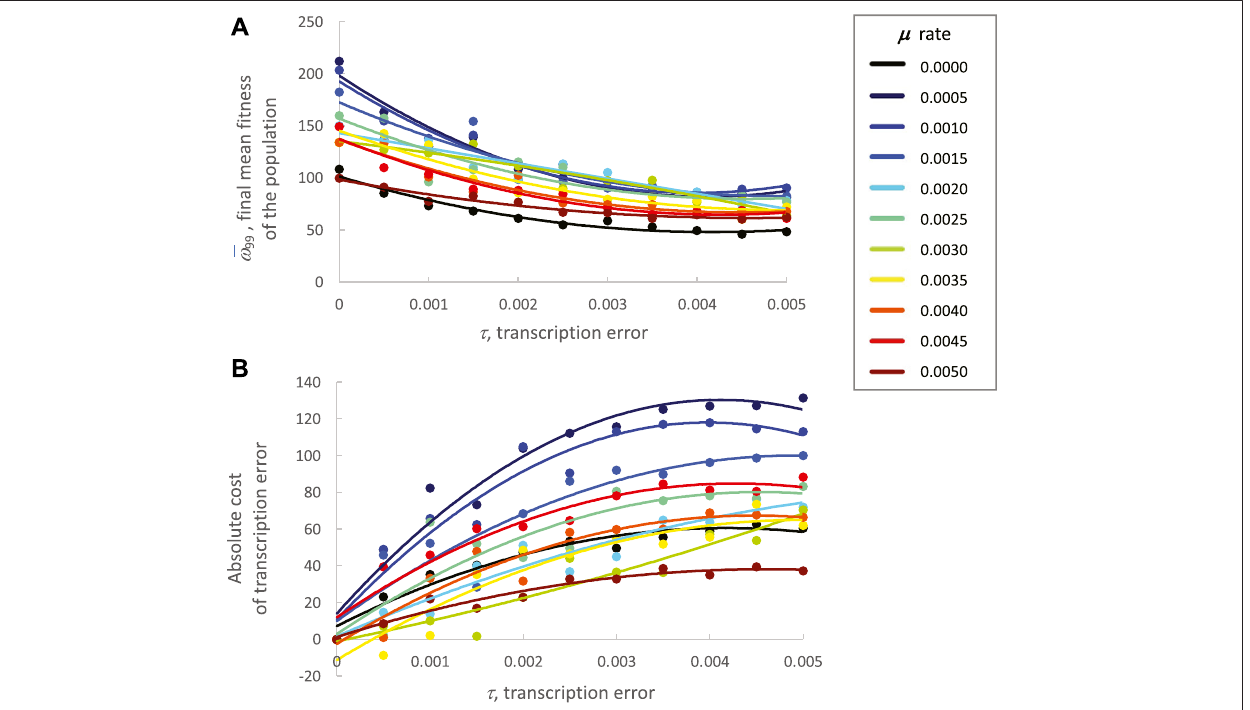
FIGURE 9 | Final mean fi tness (generation 99) of the population varies with mutation and transcription error. Note that these data are descriptive, and no statistical tests were conducted. Means are the mean fi tness of the ten populations in each condition. Curves are second-order polynomials fi t by least-squares regression. (A) Final mean fi tness. Except for 0.0005 and 0.0010 levels ofmutation, as transcription error increases, the fi nal mean fi tness of the population decreases. The relationship between rate of mutation and fi tness is more complex; low to intermediate levels of mutation, from 0.0005 to 0.0035 cluster consistently with the highest fi tness over the range of epigenetic errors. Each point is the mean of all individuals across all ten populations. (B) Cost of transcription error. The absolute cost of transcription error, measured as a loss of fi tness (difference from fi tness at 0 transcription error), is consistently high across levels of transcription error for the three lowest rates of mutation; the smallest loss across levels of transcription error occur in the populations with the highest rate of